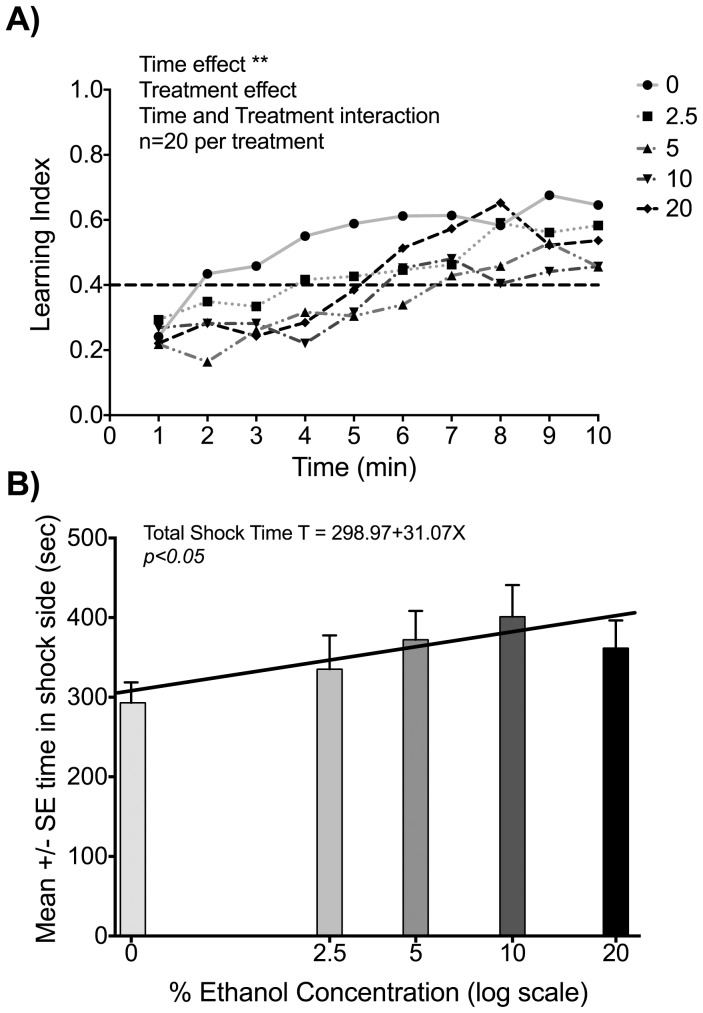
Ethanol treatment affects ESA conditioning in honey bee foragers.
A) Learning index over time for 0%, 2.5%, 5%, 10%, and 20% ethanol treatment groups (see legend on plot). ANOVA analysis resulted in non-significant treatment effect (F (36,855) = 0.59, p = 0.97), significant time effect (F (9,855) = 4.60, p<0.001) and non-significant time and treatment interaction (F (4,95) = 1.51, p = 0.21). These results demonstrate that even with ethanol administration bees were able to learn to avoid color associated with 12 V punishment. However, early phase of training differs across ethanol treatment groups, at 5% or higher ethanol treatment longer training time is required for similar improvement in learning index (see Results). B) Mean and SE of time spent in shock side for 0%, 2.5%, 5%, 10%, and 20% ethanol treatment groups. Increased ethanol concentration treatment is associated with an increase in time spent in the shock side during the ESA conditioning, indicating lower learning performance. Linear regression of mean time spent in the shock side is statistically significant (p<0.05).